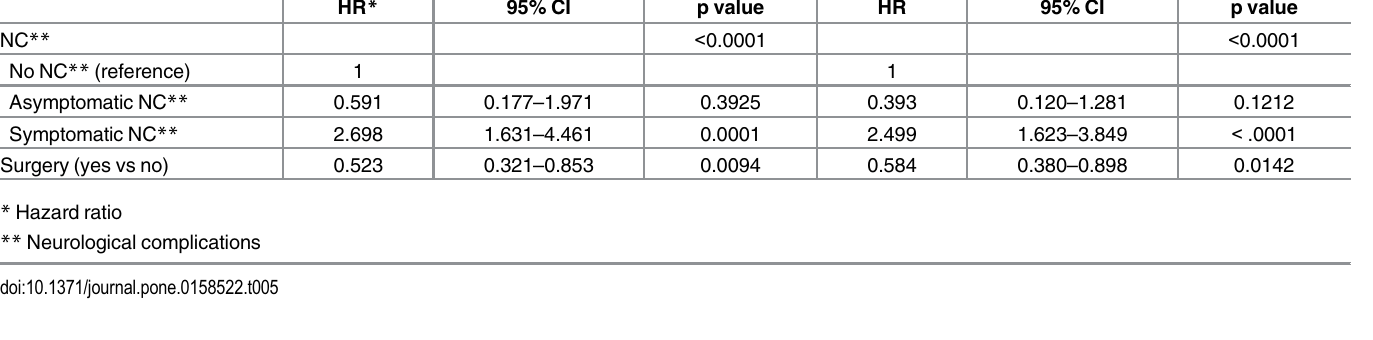
Table 5. Relationship between neurological complications and mortality among 283 patients with neuroimaging procedure: multivariate analysis adjusted for surgery. In-hospital